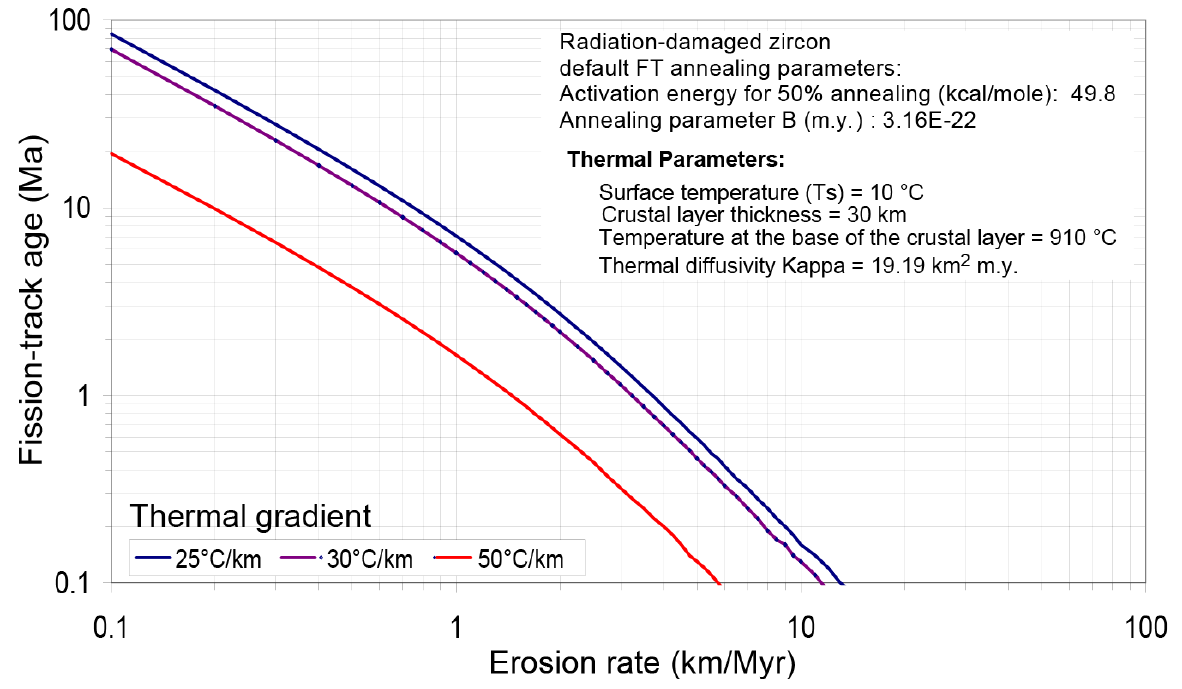
Figure 4. Relationship between zircon fission-track age and erosion rate, depending on initial thermal gradient and steady-state conditions. Calculations based on the Age2edot program of Brandon